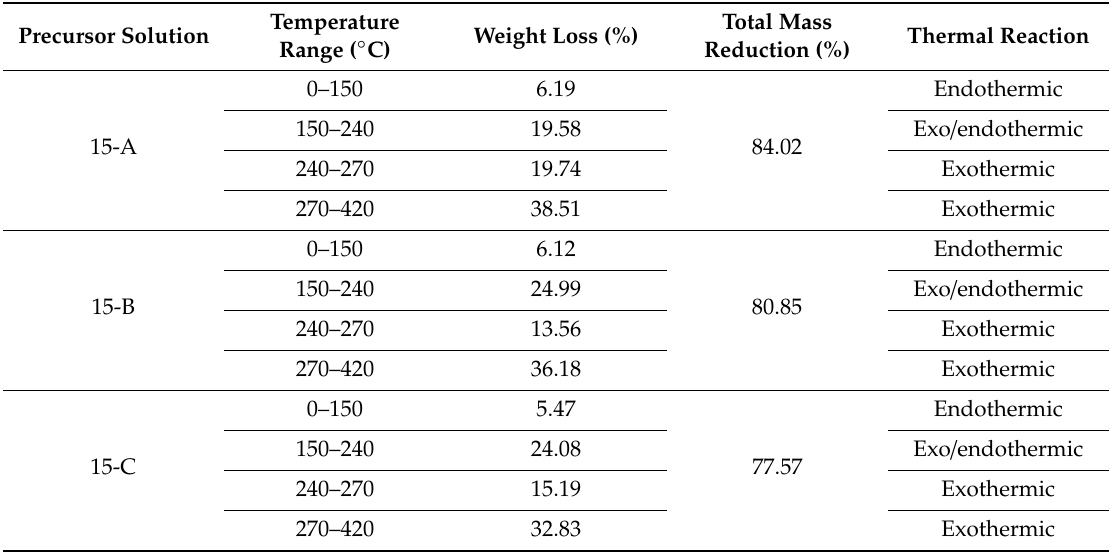
Table 2. The thermal reaction classification of the TGA